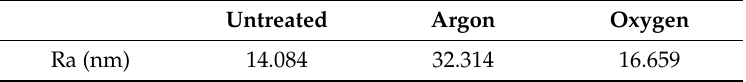
Figure 13. AFM of HDPE samples ( A ) untreated, ( B ) treated with an argon plasma, ( C ) treated with oxygen plasma. Table 4. Average roughness obtained from treated and untreated